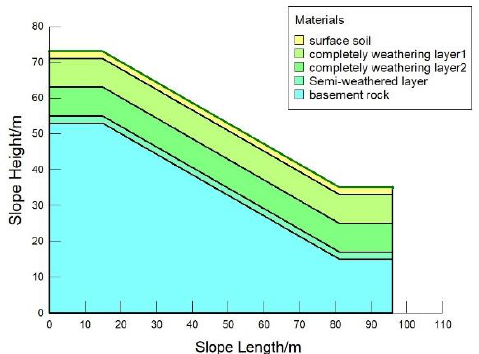
Figure 9. Slope model (with a slope height of 38 m and a slope angle of 30°).